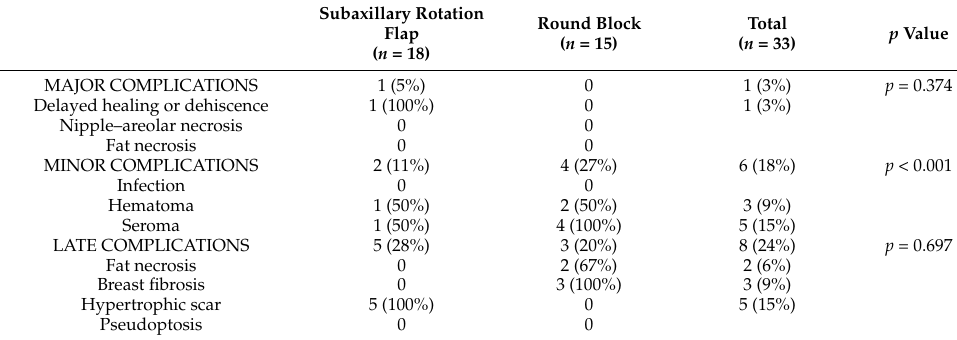
Table 3. Postoperative